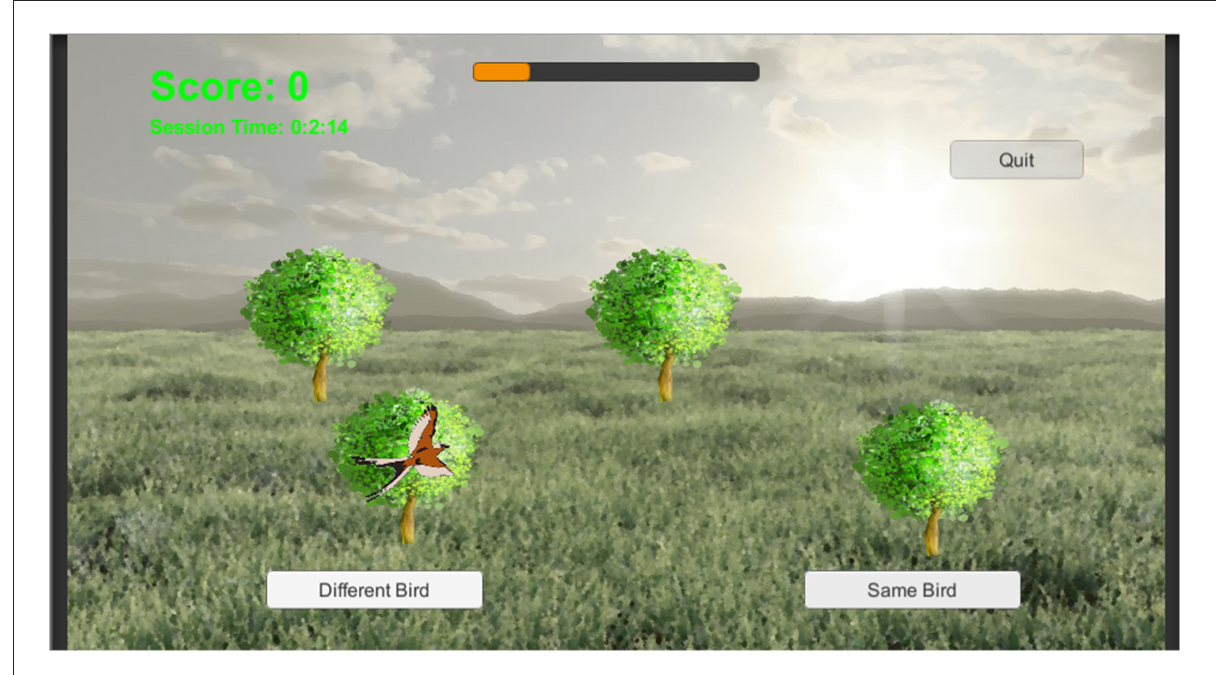
FIGURE1 A single trial from BWGU, depicting a four-context